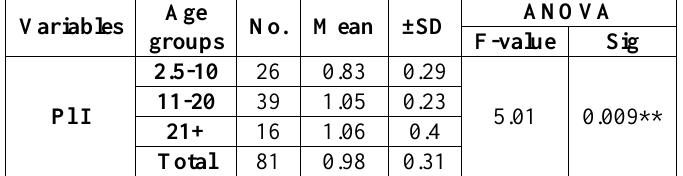
Table 3: Plaque index (mean and standard deviation) among patients with Juvenile Idiopathic Arthritis according to age Age Variables No. Mean groups